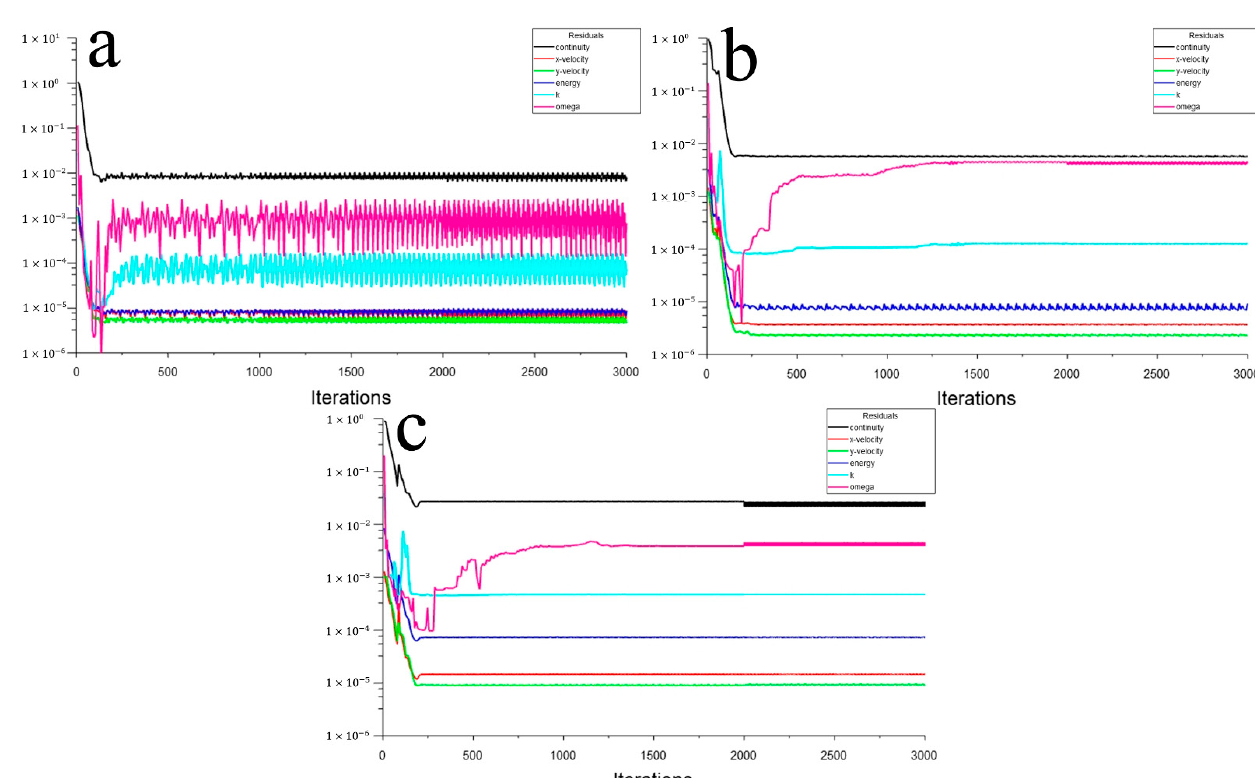
Figure 7. The residuals with different attack angles ( a ) 0°; ( b ) 5°; ( c ) 10°. According to the contours of all groups (a–D) in Figures 4–6, the finite element cal- culation results of three chosen calculated objects (Wall 0, Wall 1, Wall 2) from the hyper- sonic flying object’s warhead are plotted to scatter graphs in Figures 8–10. Figure 8a–c is